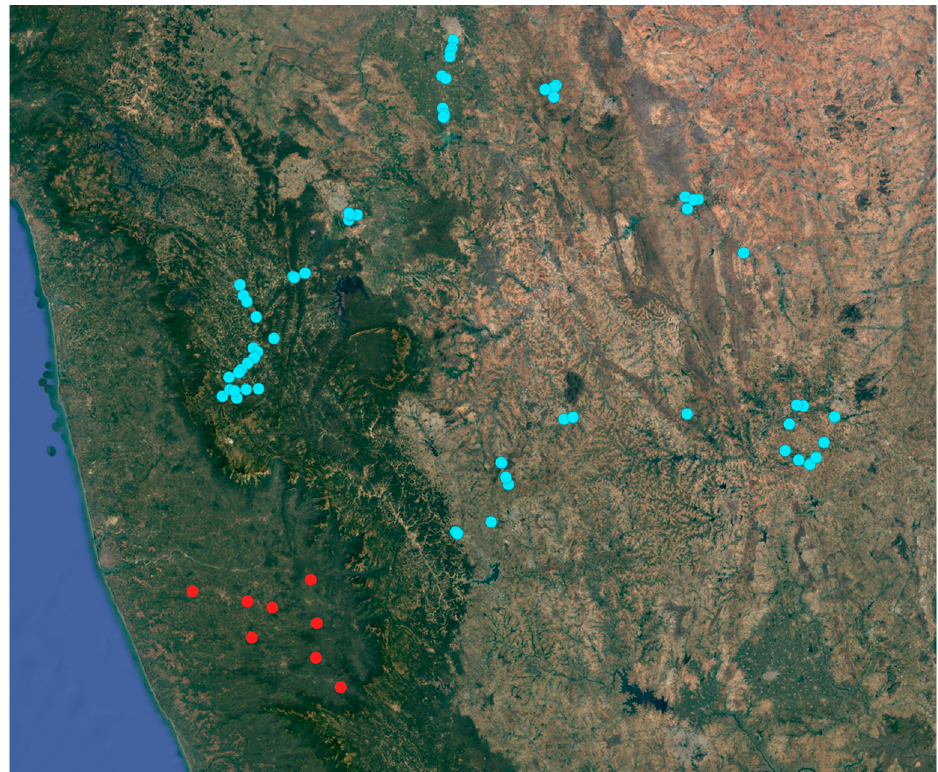
Figure 5. Map of the areca palm plantation surveyed; sites where no infestation has been detected (blue circle), sites where damages caused by X. crassiusculus have been observed.